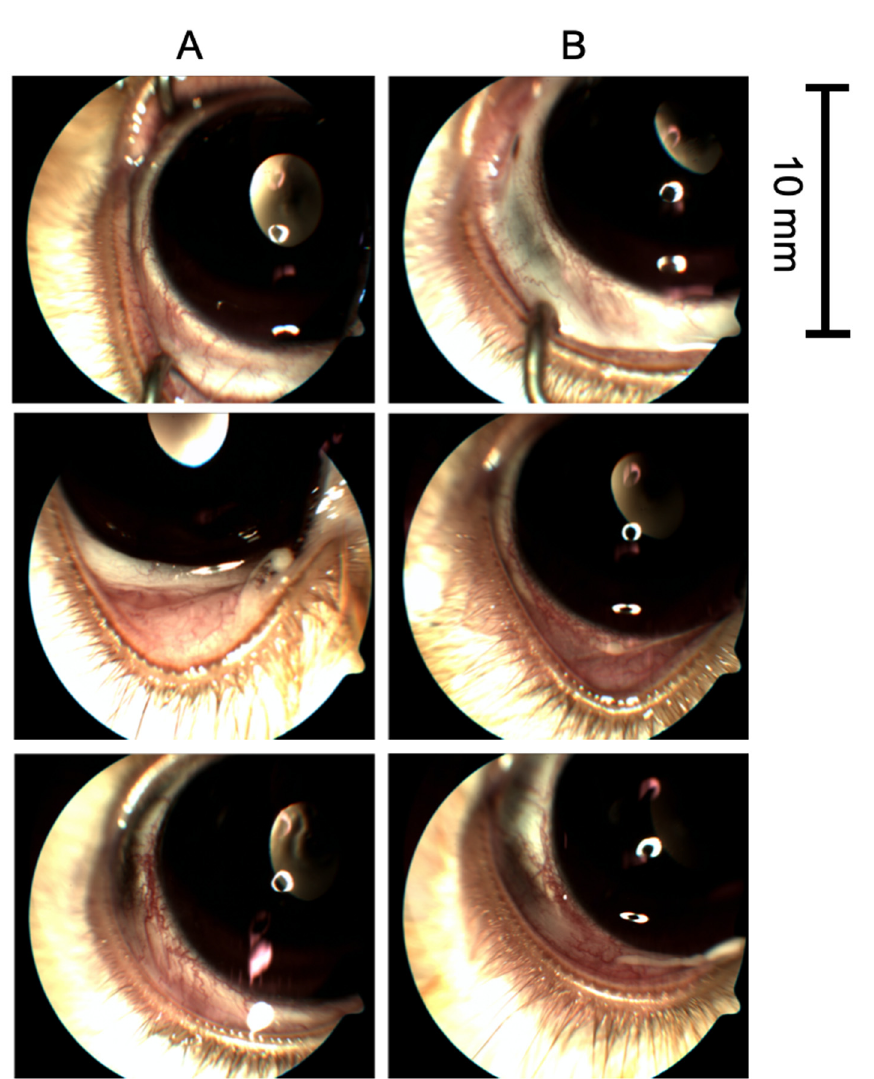
Figure 2. Representative images of study and control eyes. ( A ) Study eyes and ( B ) control eyes photographs show no inflammation, swelling, or discharge after the instillation of triamcinolone acetonide-loaded liposomes formulation (TALF) or placebo solution, respectively.